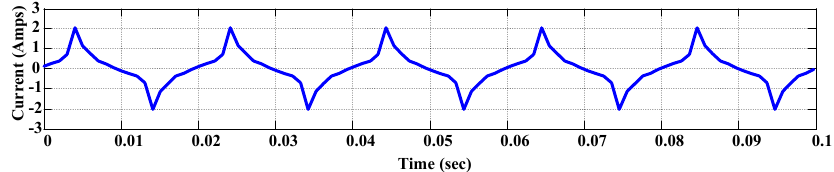
Figure 8. All four loads. CFL + LED + exhaust fan + SMPS of the PC load waveform. From single-load operation to four-load operation, the load current waveforms are unique, indicating that the percentage THD is di ff erent for all load combinations. Therefore, percentage THD can be safely used for load identification e ff ectively. The percentage THDs measured by EDLIFFT with a 4MSW using an NI-cRIO 9082 data acquisition system described in Figure 4 are tabulated in Table